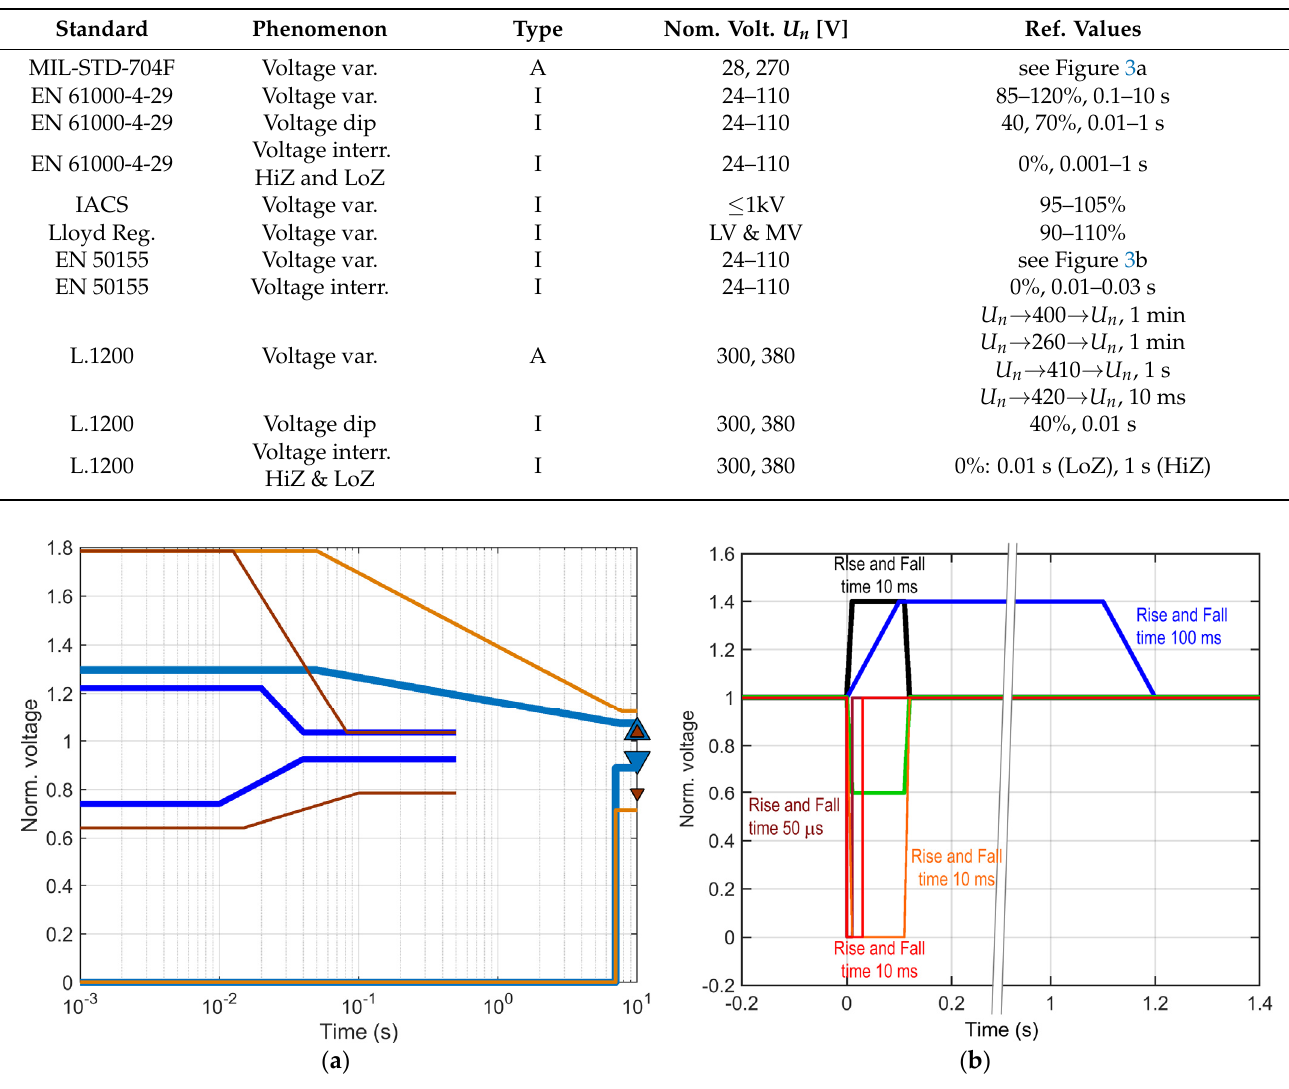
Table 5. Limits and test values for transient phenomena (voltage swells, sags, and interruptions) (E = emission, I = immunity, G = generator, A = ambient specification).